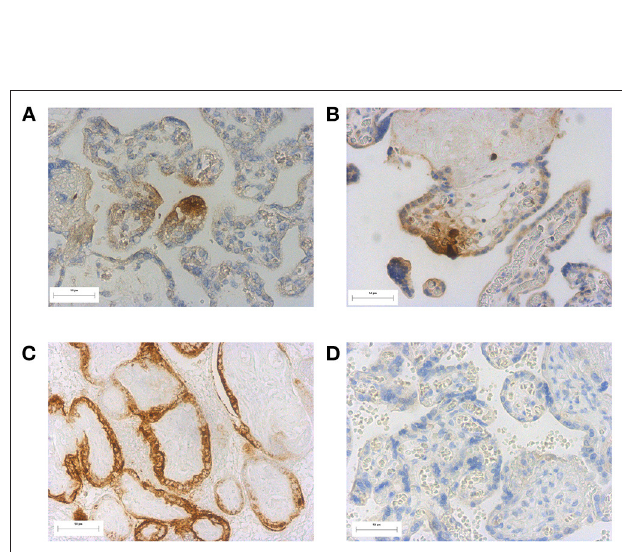
FIGURE 3 | SARS-CoV-2 spike staining in placentas (A) and (B) possible positive staining in a placenta from a participant within the active COVID group, (C) positive staining of a previously identified SARS-CoV-2 positive placenta (positive control) (D) negative SARS-CoV-2 spike protein staining in an unaffected placenta. Magnification